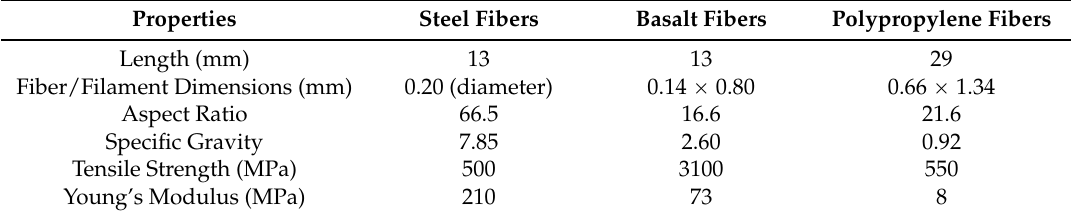
Table 2. Physical properties of